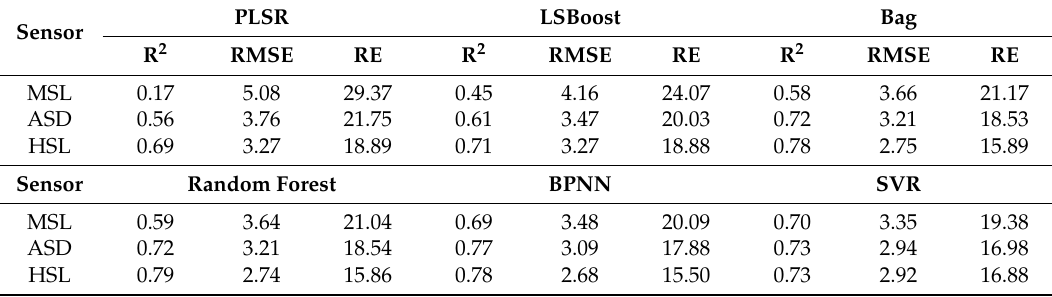
Table 1. Regression performance of the six algorithms with optimal parameters (PLSR, LSBoost, Bag, RF, BPNN, and SVR; unit of RMSE: